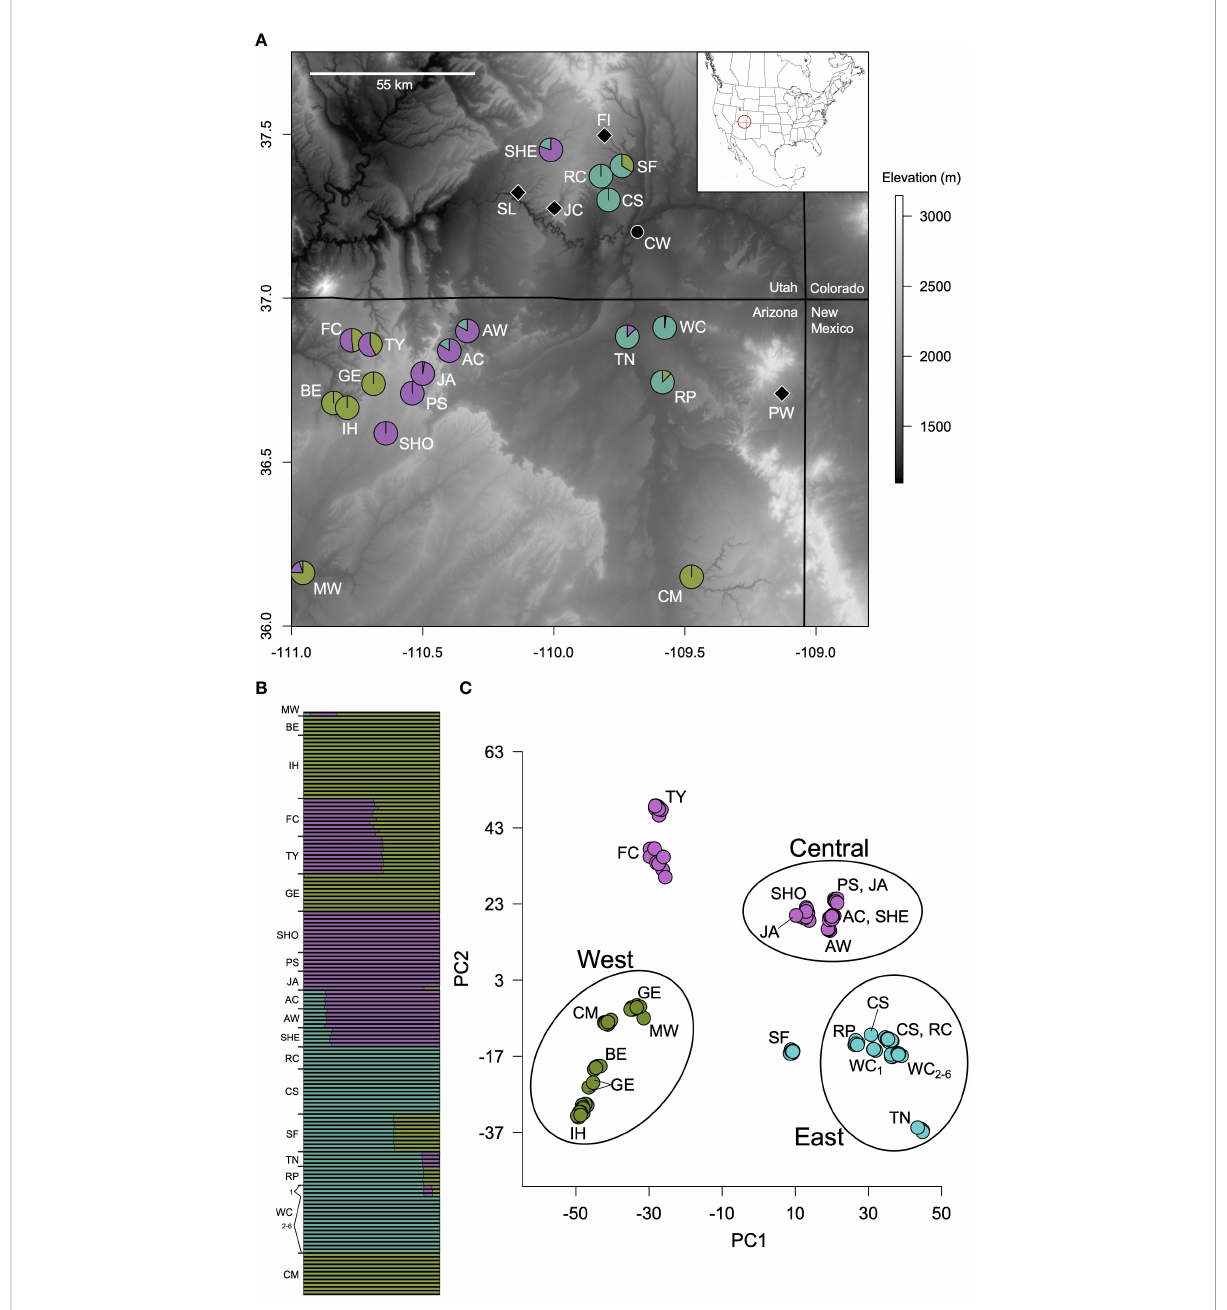
FIGURE 1 (A) Carex specuicola (circles) and C . utahensis (diamonds) sampling sites across Arizona and Utah. Colored pie charts for C . specuicola represent proportional ancestry coef fi cients averaged across individuals at a site; Chinle Wash (the black circle) was not included in Structure analyses due to putative admixture with C . utahensis . Subsites are grouped based on the uniformity of ancestry coef fi cients across individuals. (B) K = 3 Structure result showing ancestry coef fi cients across all individuals. (C) Principal component analysis of genomic variation within Carex specuicola . PC1 and PC2 account for 17.06% and 9.25% of variance, respectively. Individuals are colored according to their dominant ancestry coef fi cient. Sampling sites not contained within a circle are highly admixed according to Structure analyses. Individuals from sampling sites form tight clusters except for four individuals highlighted by black lines. Conservation implications for genetically de fi ned populations (West, Central, East) are discussed in the text. See Table 1 for sites names associated with